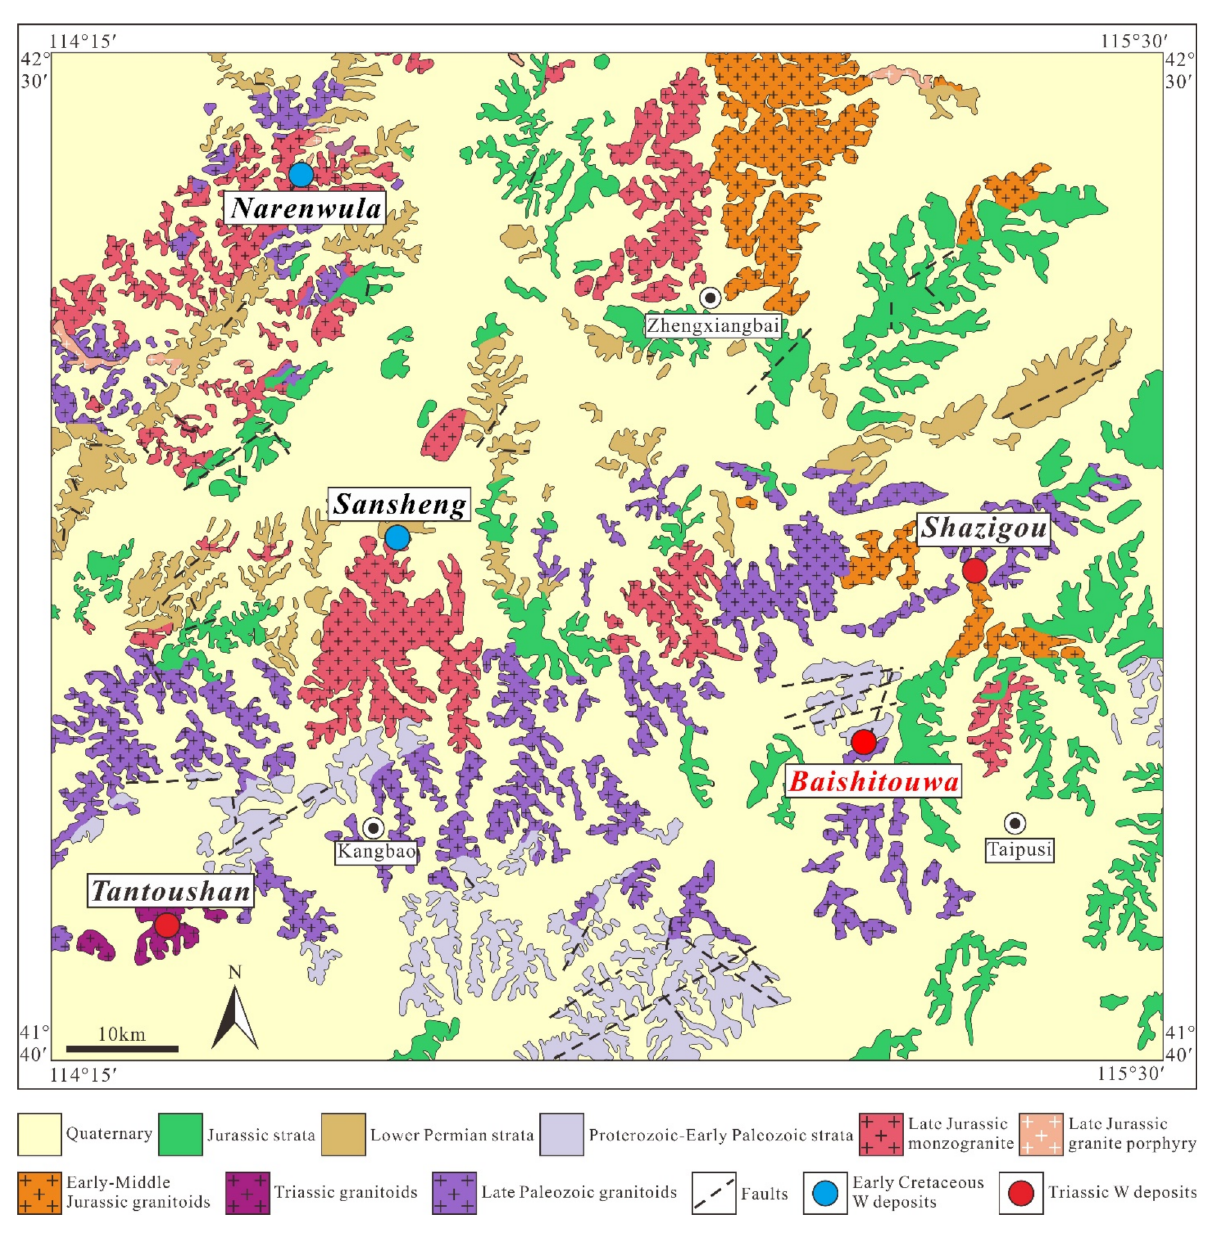
Figure 2. Schematic regional geological map of the Baishitouwa W deposit (after